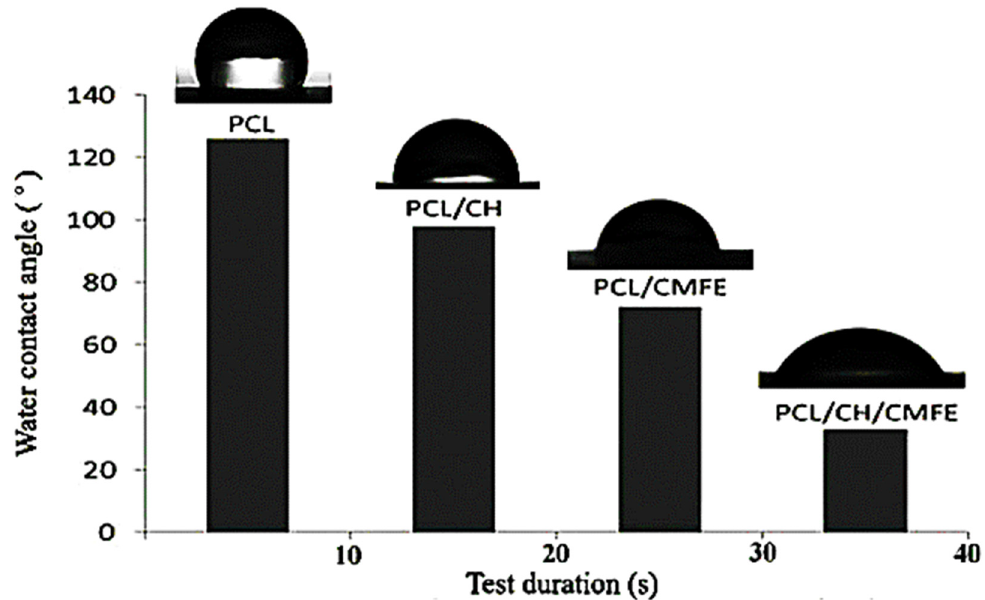
Figure 5. Contact angle characterization of the nanofibrous membranes.